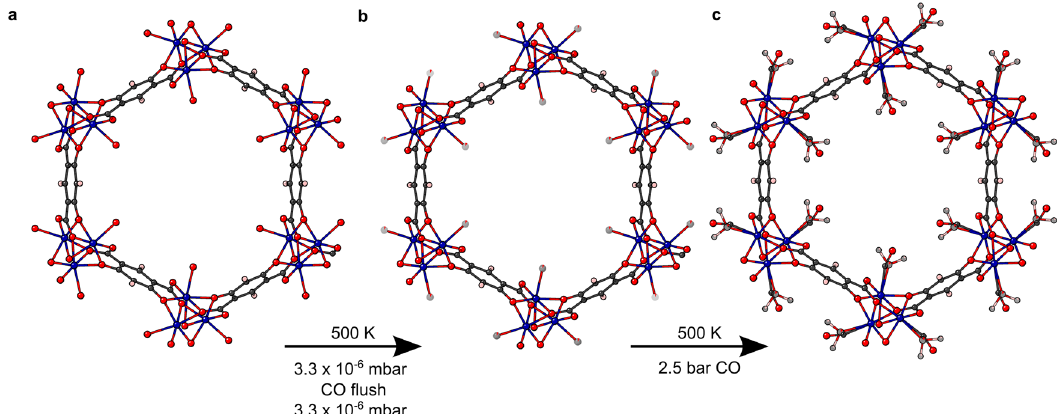
Fig. 3 Depictions of the crystal structure of Co-4,6-dhip along the crystallographic c -axis under different gas loading conditions, with 40% space fi lling spheres. a Hydrated structure at room temperature and ambient pressure. b activated structure at 500 K and 3.3 × 10 − 6 mbar, with 9.0(4)% water occupancy, CCDC number: 2208828. c CO loaded structure at 500 K and 2.5 bar CO pressure, with 10.7(15)% CO loading and 15.2(15)% water, CCDC number: 2208827.